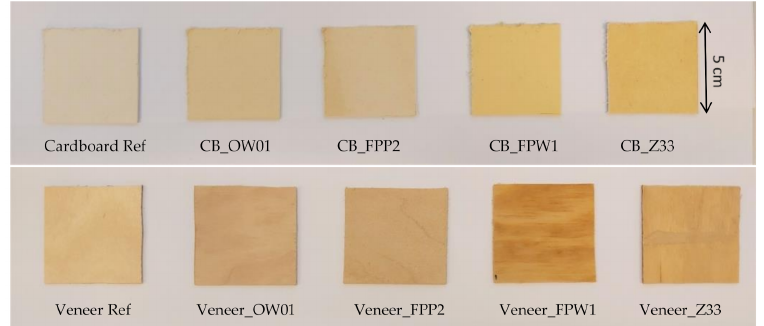
Figure 1. Images of fire-retardant-coated samples (coated side up). Sample size 5 × 5